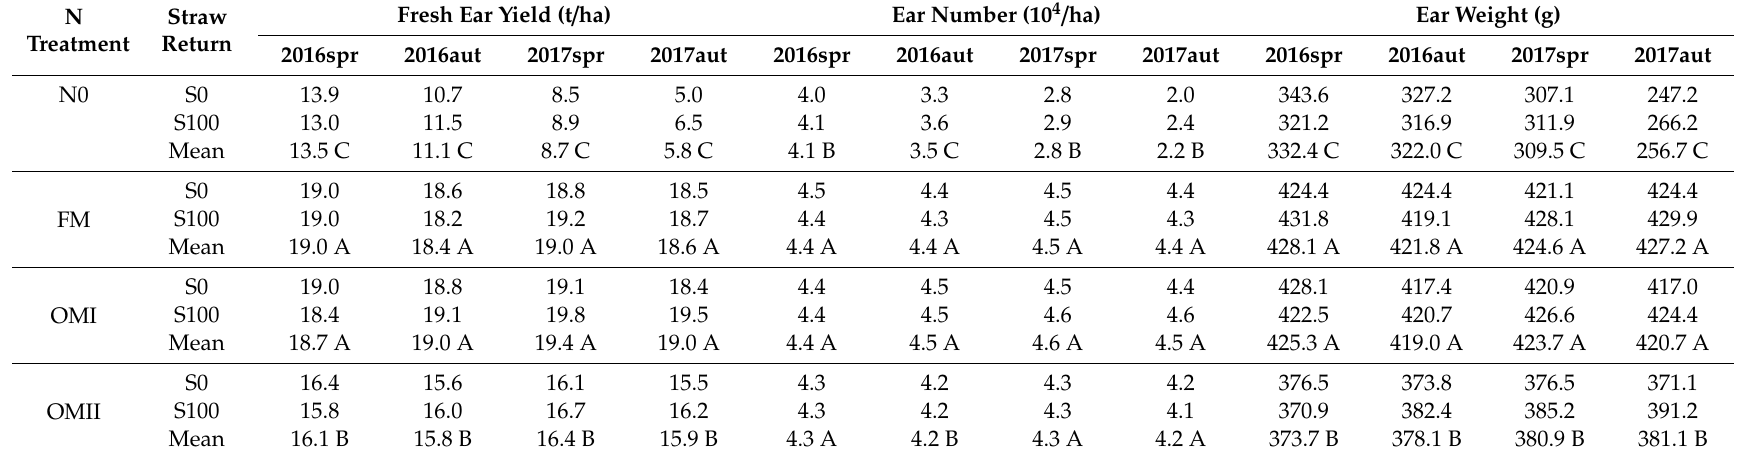
Table 5. Yield and yield components of sweet corn under di ff erent N management and straw management